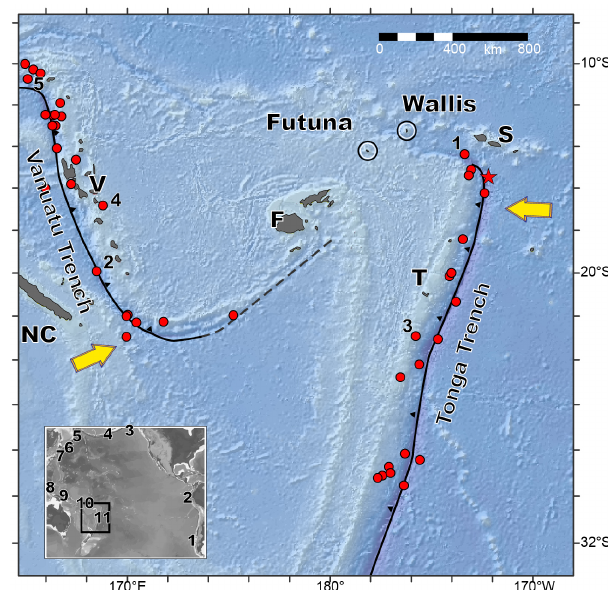
Figure 1. The Southwest Pacific region – star indicates location of the 29 September 2009 M W = 8.1 South Pacific earthquake. Earthquakes M > 8 are indicated with red dots Source USGS (http: //earthquake.usgs.gov/). Earthquakes mentioned in the text are